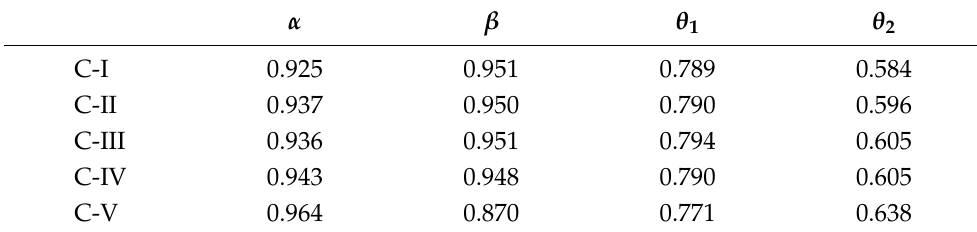
Table 3. The acceptance rates for α , β , θ 1 and θ 2